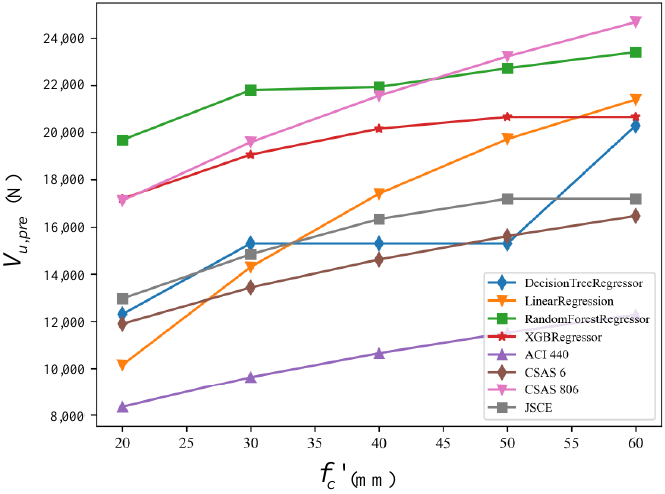
Figure 13. Effects of concrete strength on shear performance.